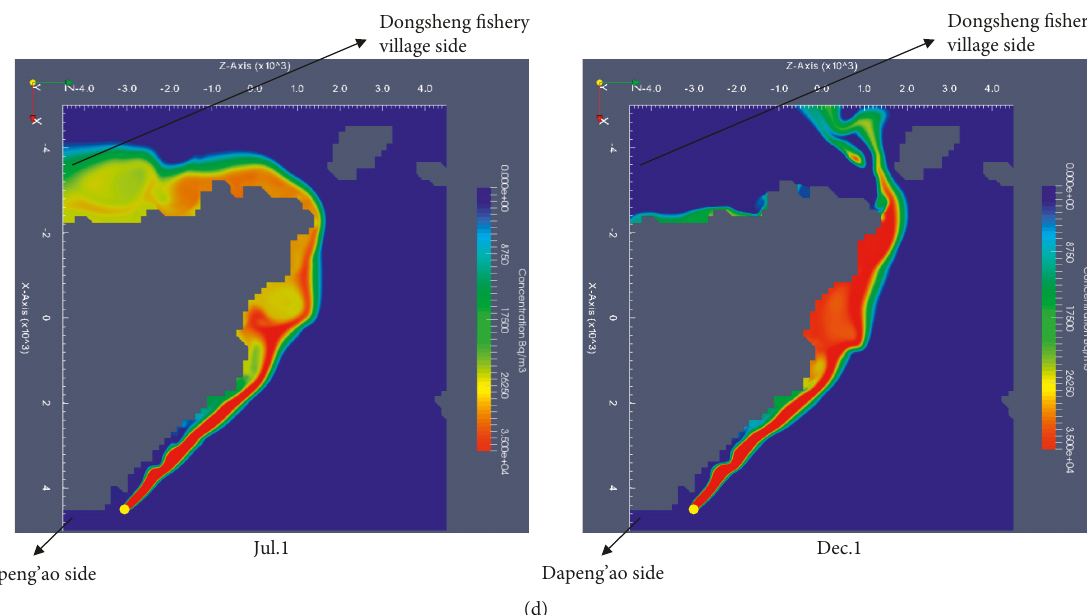
Figure 8: Simulation of the released 137 Cs concentration in 12 hours on Jul. 1 and Dec. 1. (a) t � 1 h. (b) t � 4h. (c) t � 11h. (d) t � 12h.